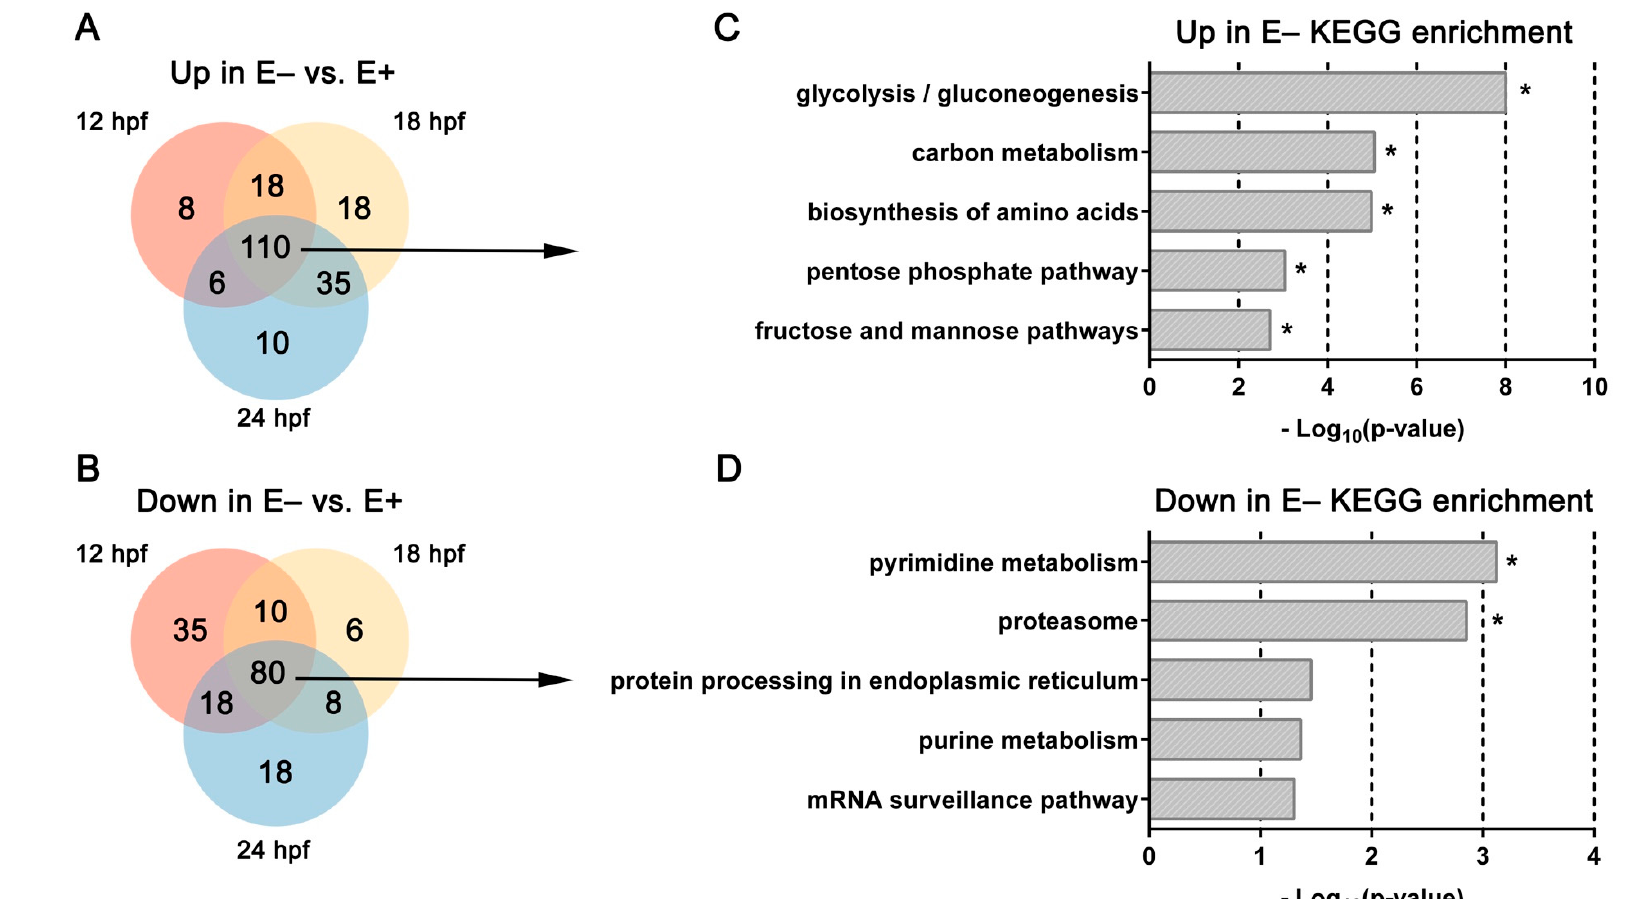
Figure 2. Venn diagrams and KEGG pathways enriched by over representation analysis of differentially expressed genes changed consistently over time. ( A , B ) Venn diagrams separating DE genes consistently ( B ) increased or ( C ) decreased in E– embryos relative to E+ embryos at each age. ( C , D ) KEGG pathways associated with DE genes ( FDR < 0.1) consistently ( C ) increased or decreased ( D ) in E– embryos vs. E+ embryos at each time point (12, 18, and 24 hpf). * indicates significant FDR < 0.25.